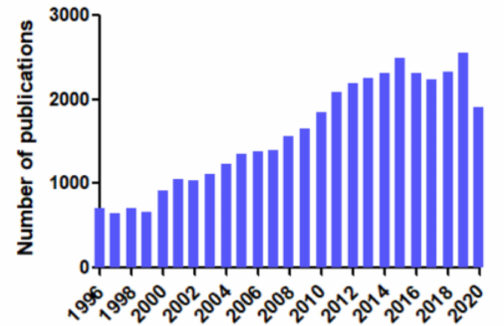
Figure 1. Rising number of publications in H 2 S research fields. A search for original and review articles published from 1996 to 2020 was performed in the PubMed database (www.ncbi.nlm.nih. gov/pubmed, accessed on 10 June 2021) using the key words “hydrogen